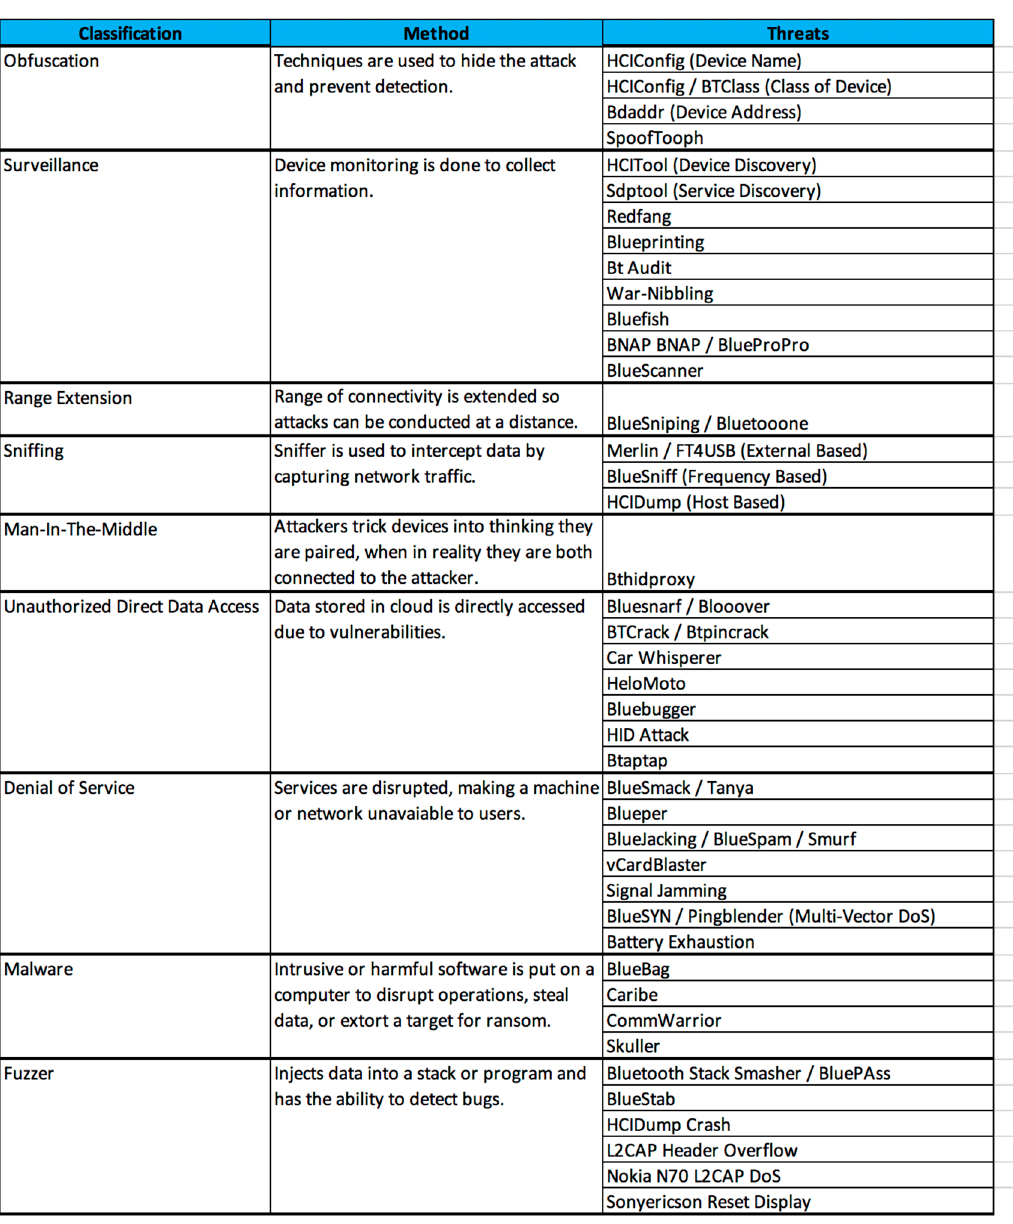
Figure 6. Bluetooth Threat Taxonomy.